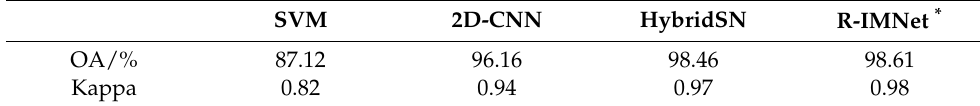
Table 2. Classification precision table of each model.